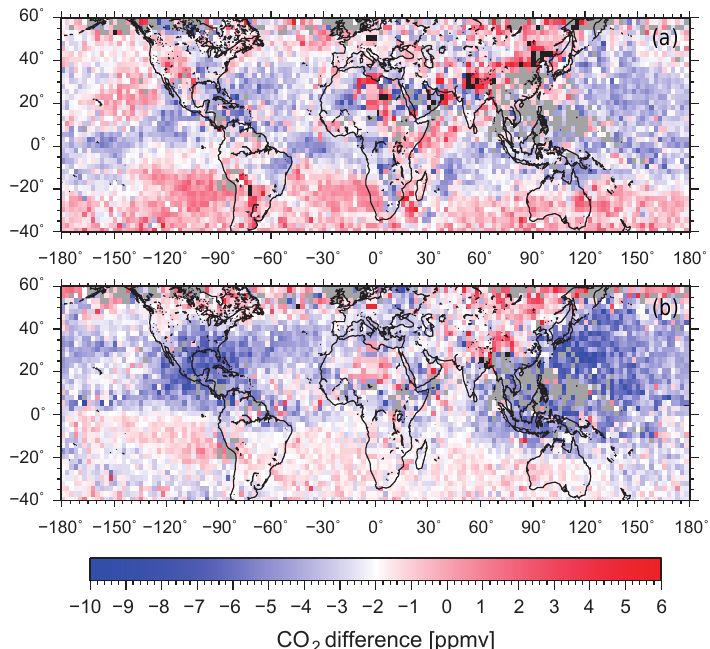
Figure 11. Latitude–longitude cross sections of differences in monthly averages of GOSAT/TANSO-FTS TIR CO 2 data and NICAM-TM CO 2 data with TIR CO 2 averaging kernel functions (TIR minus NICAM-TM) in July 2010. The upper and lower panels show the results on 682hPa (retrieval layer 3) and 314hPa (retrieval layer 8), respectively. There are no GOSAT/TANSO-FTS TIR CO 2 data in gray-shaded